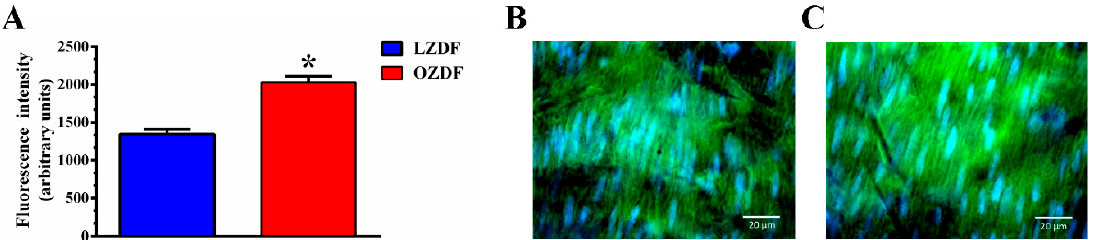
Figure 11. SERCA2B protein is upregulated in native aortic endothelium of obese Zucker rats. Semiquantitative analysis ( A ) of immunofluorescent staining of the endothelial monolayer of rat aorta revealed that SERC2B expression was up-regulated in OZDF ( C ) as compared to LZDF ( B ) rats (SERCA2B: red; blue: cell nuclei). The asterisk indicates p < 0.05.